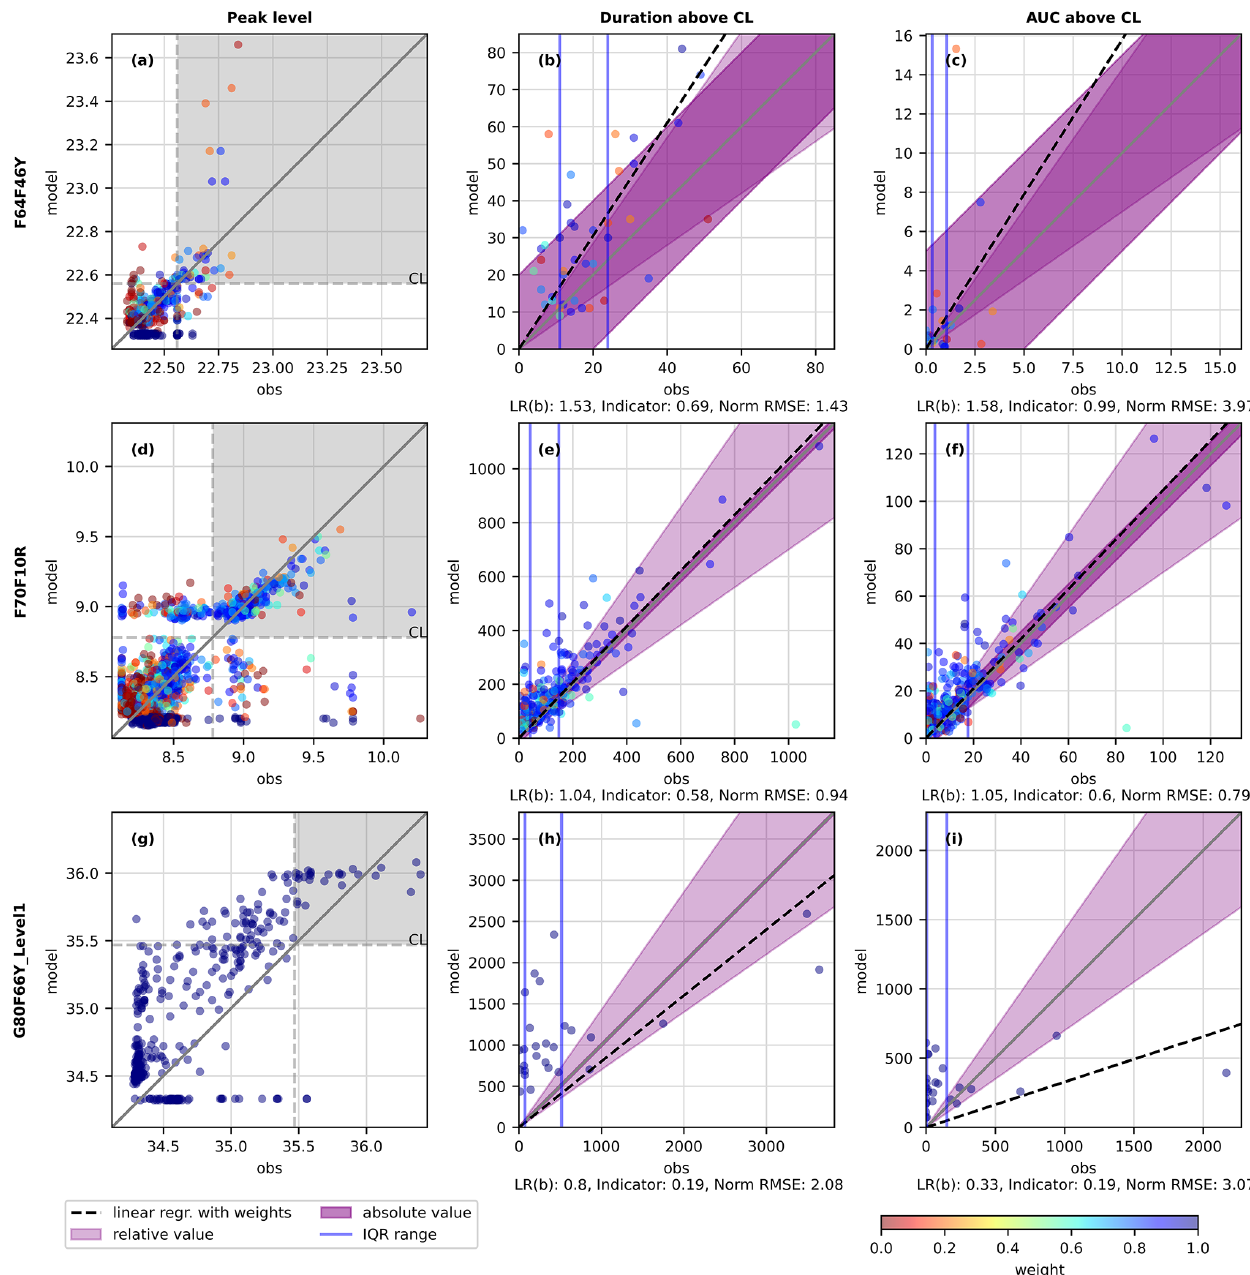
Figure 9. Multi-event signature comparison plots for different sites (rows) and signatures (columns). (a, d, g) The true positive ranges are indicated (grey area), where peak level is above CL for both observed and modelled events. (b, c, e, f, h, i) The true positive events are the only events plotted for the two signatures, where the duration above CL and AUC above CL is seen. An illustration of important elements for the three methods, i.e. linear regression (dashed black line), indicator function (acceptance areas with purple), and normalised RMSE (blue lines indicating IQR), is given. The weight of each event is illustrated with the colour bar. The 1 : 1 line is plotted with a solid grey line. The score of the statistical methods is indicated below the multi-event signature comparison